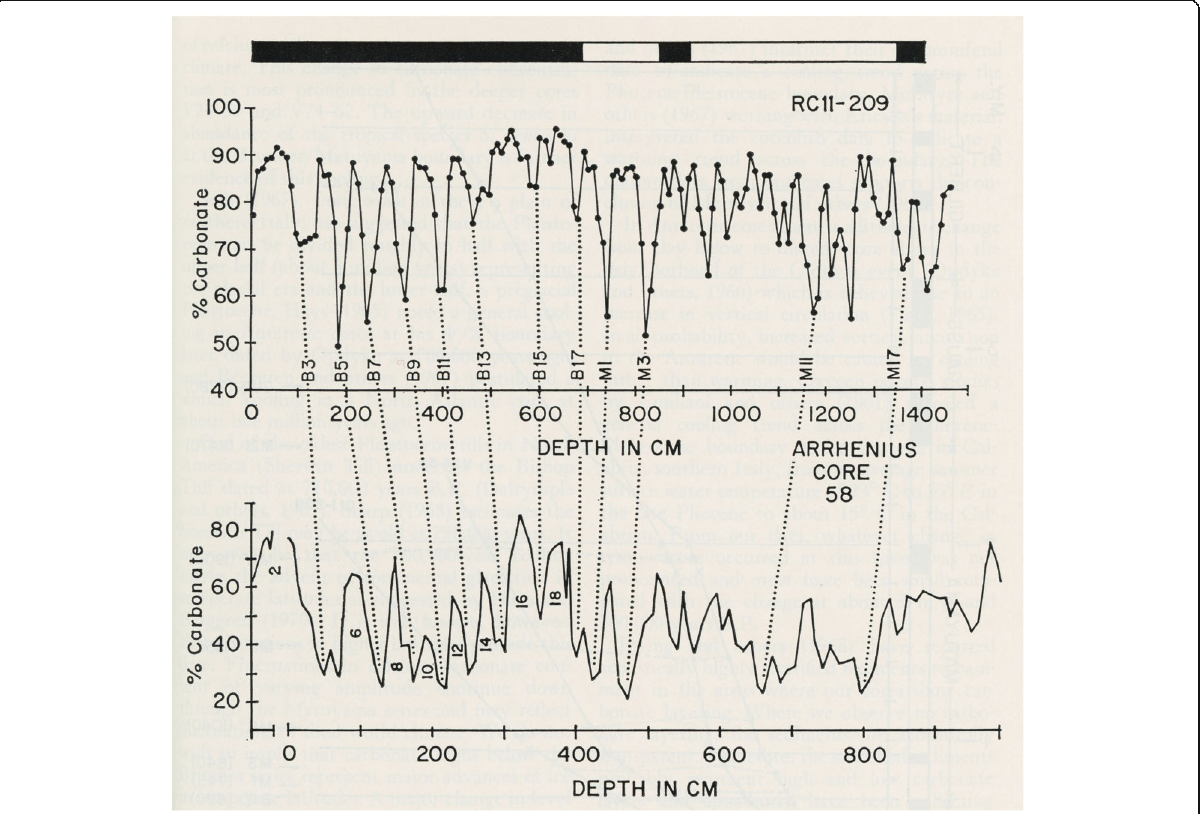
Fig. 5 Reproduction of fig. 14 in Hays et al. (1969) showing correlation between carbonate percentage in equatorial Pacific core RC11-209 and that of east equatorial Pacific core 58 of Arrhenius (1952). Carbonate cycle B17 in core RC11-209 corresponds to an unlabelled cycle in Arrhenius ’ core 58. This would have been cycle 19 had Arrhenius continued labelling. Cycle B17 aligns with the Matuyama – Brunhes paleomagnetic reversal